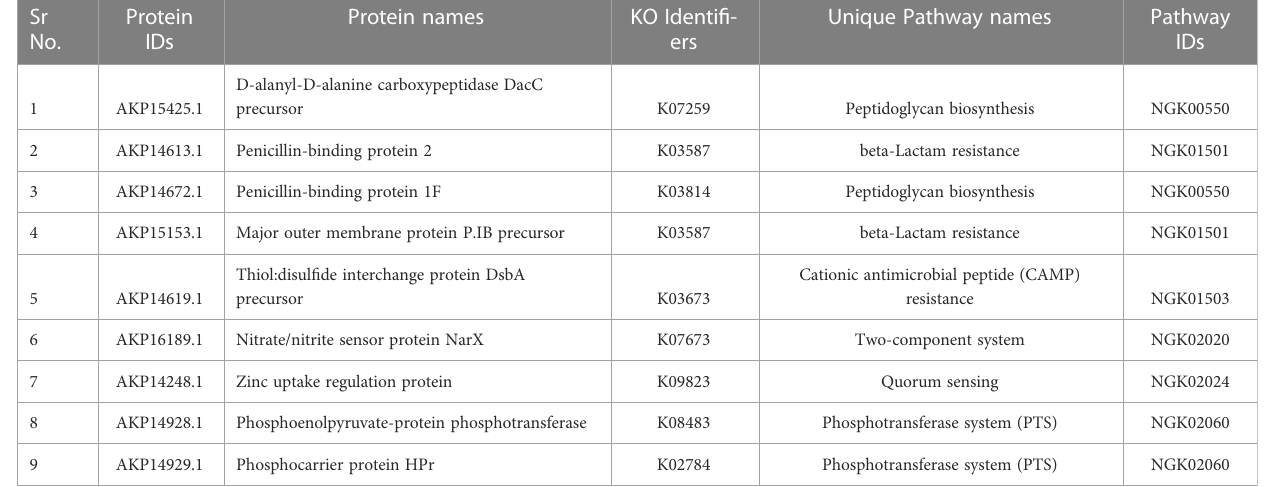
TABLE 1 Neisseria gonorrhoeae proteins involved in the unique metabolic pathways with their respective pathway IDs. Sr